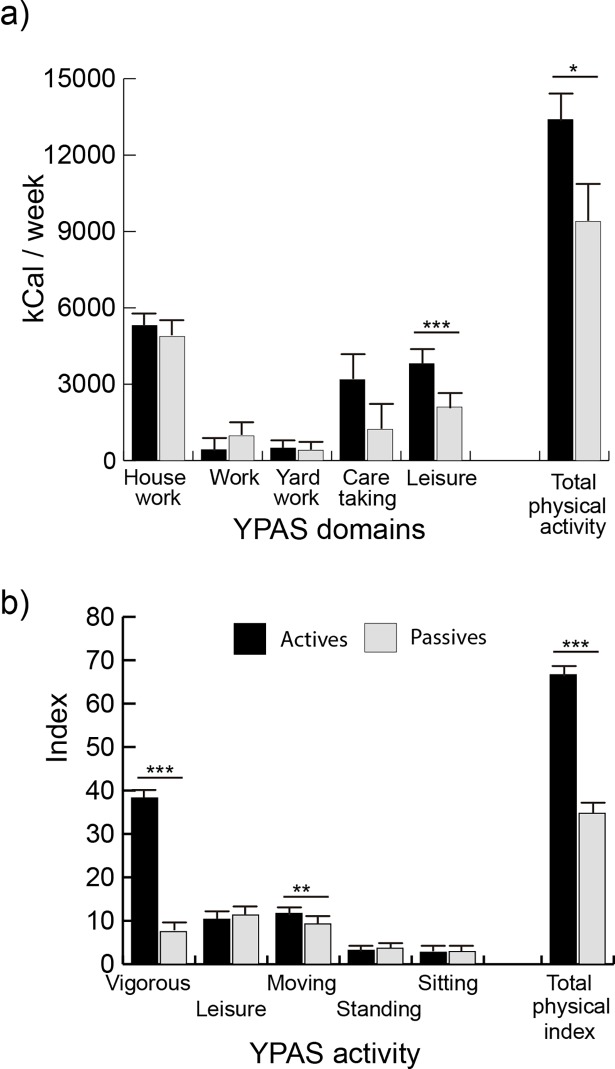
Post-hoc comparisons between the groups in the YPAS variables.* p < .05, ** p < .01, *** p < .001.